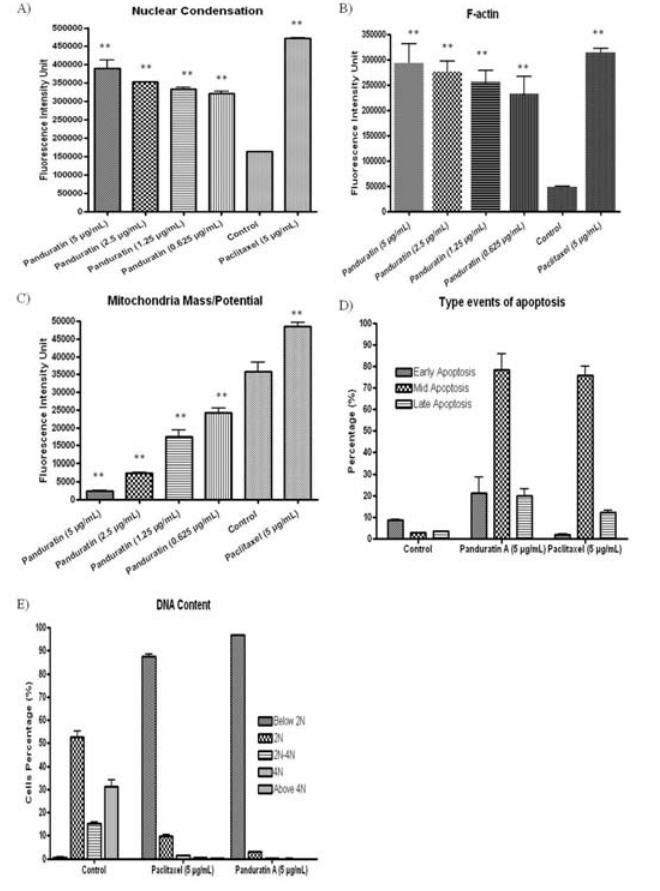
Figure 9. Quantitative analysis of panduratin A mediated. Dose-response histogram for each apoptosis parameter. Panduratin A increased the percentage of cells with condensed chromatin and F-action content in a concentration-dependent fashion at the same time caused loss of mitochondrial